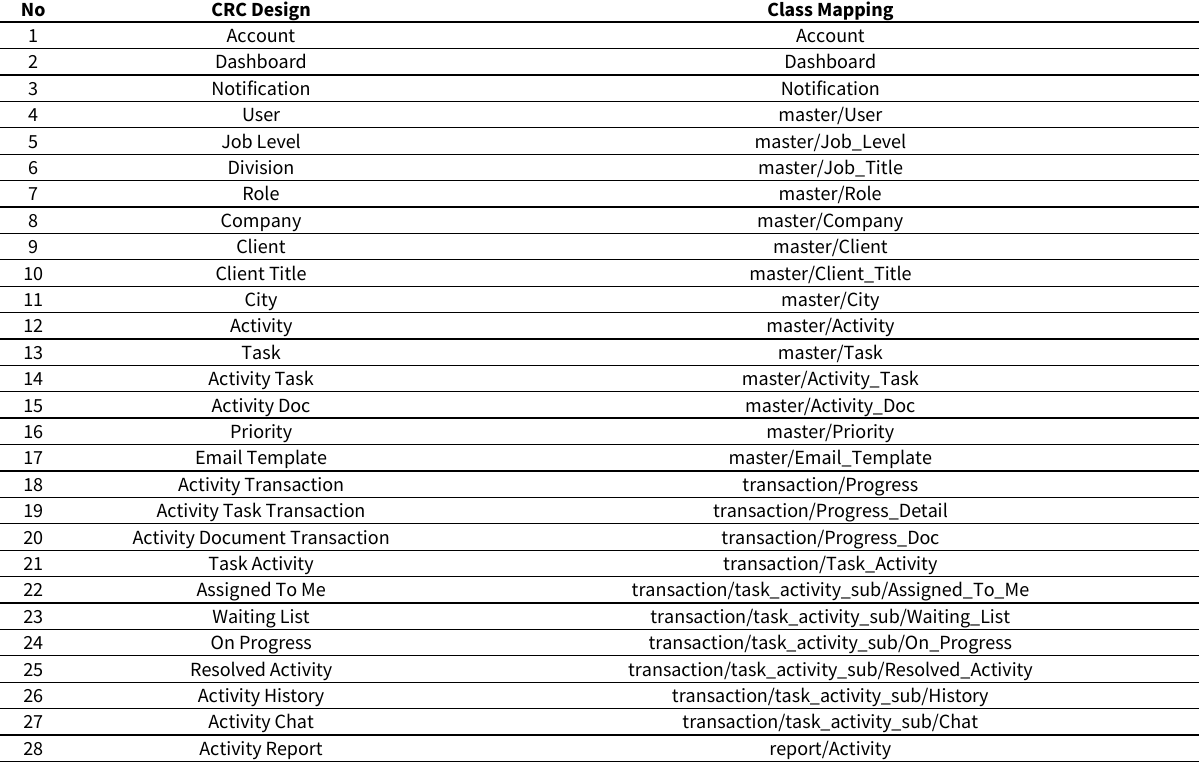
Table 3. Design CRC and Mapping of